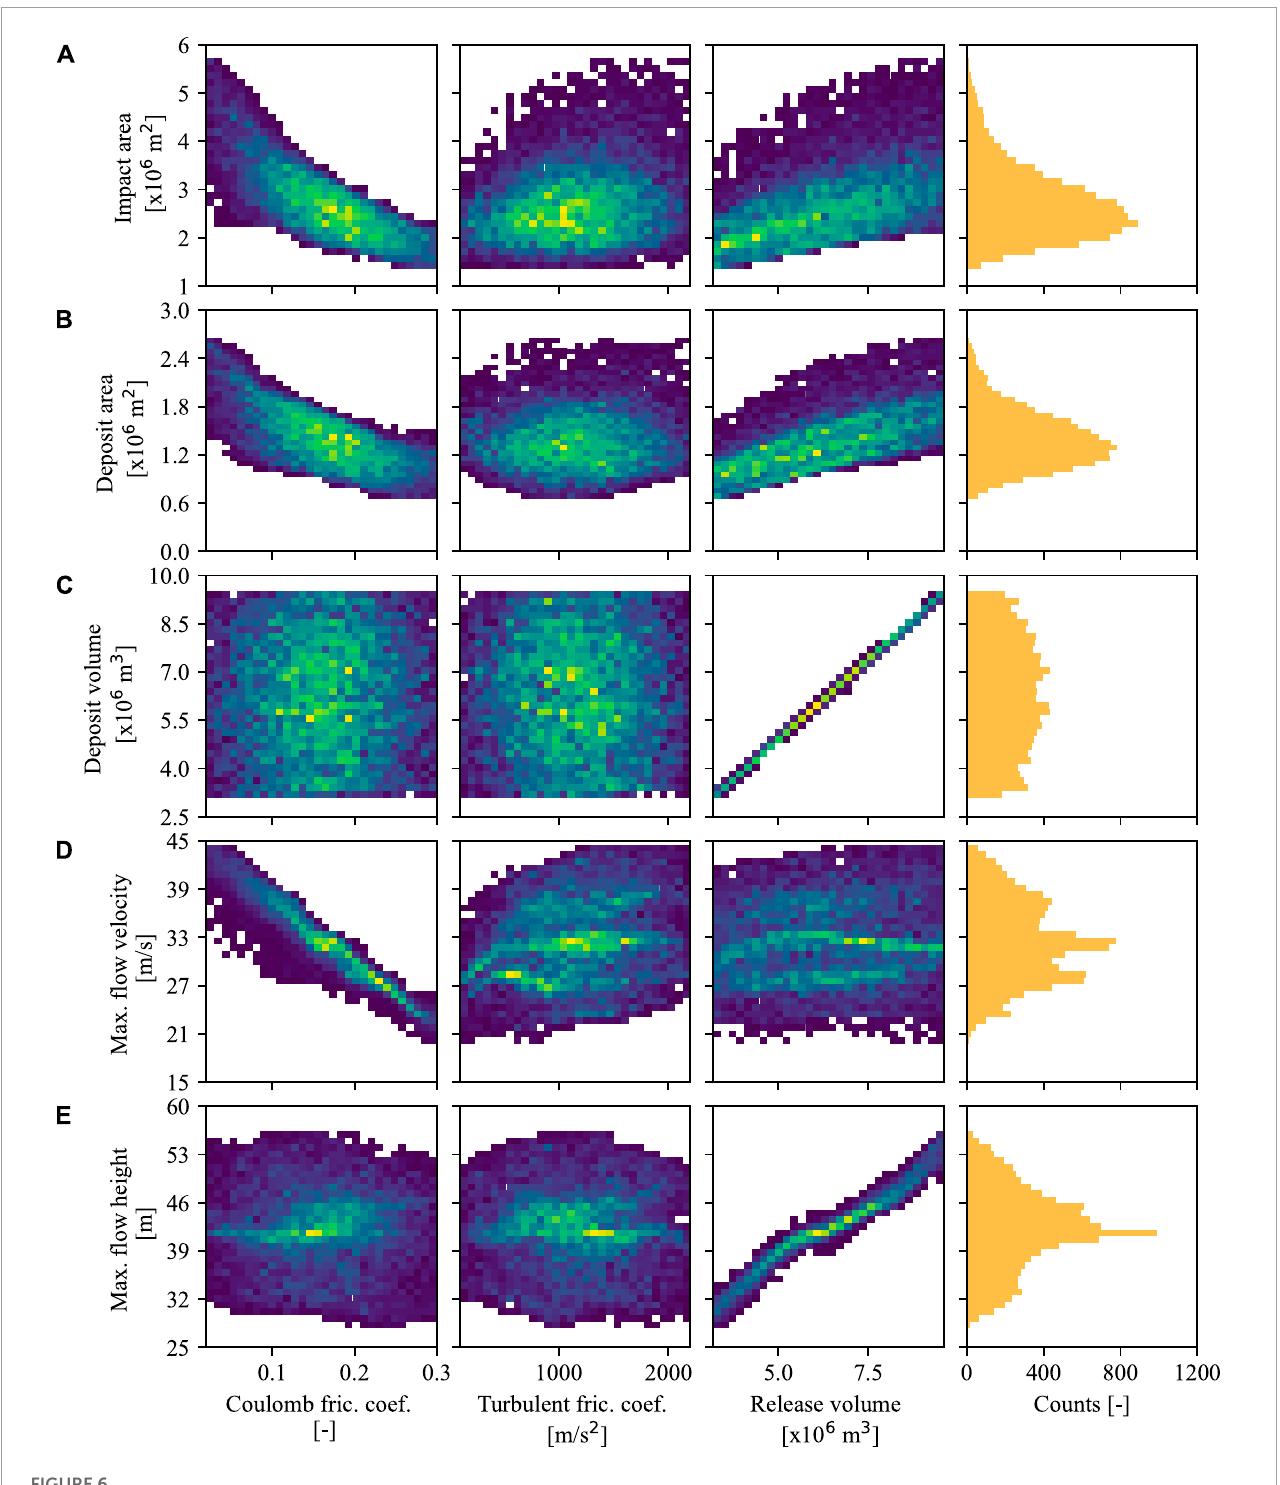
FIGURE 6 Relationships and histograms of (A) impact area, (B) deposit area, (C) deposit volume, (D) maximum flow velocity and (E) maximum flow height at ( x , y ) = (1490100, 5204100) from Acheron rock avalanche with uncertain parameters used in the Monte Carlo analysis with coefficient of variation of 50%.